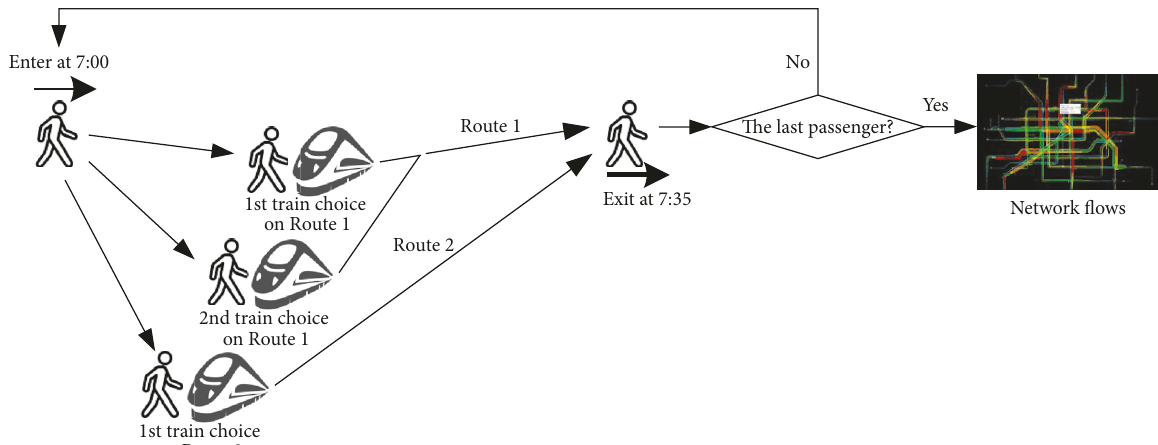
Figure 1: Relationship among train choice, route choice, and flow